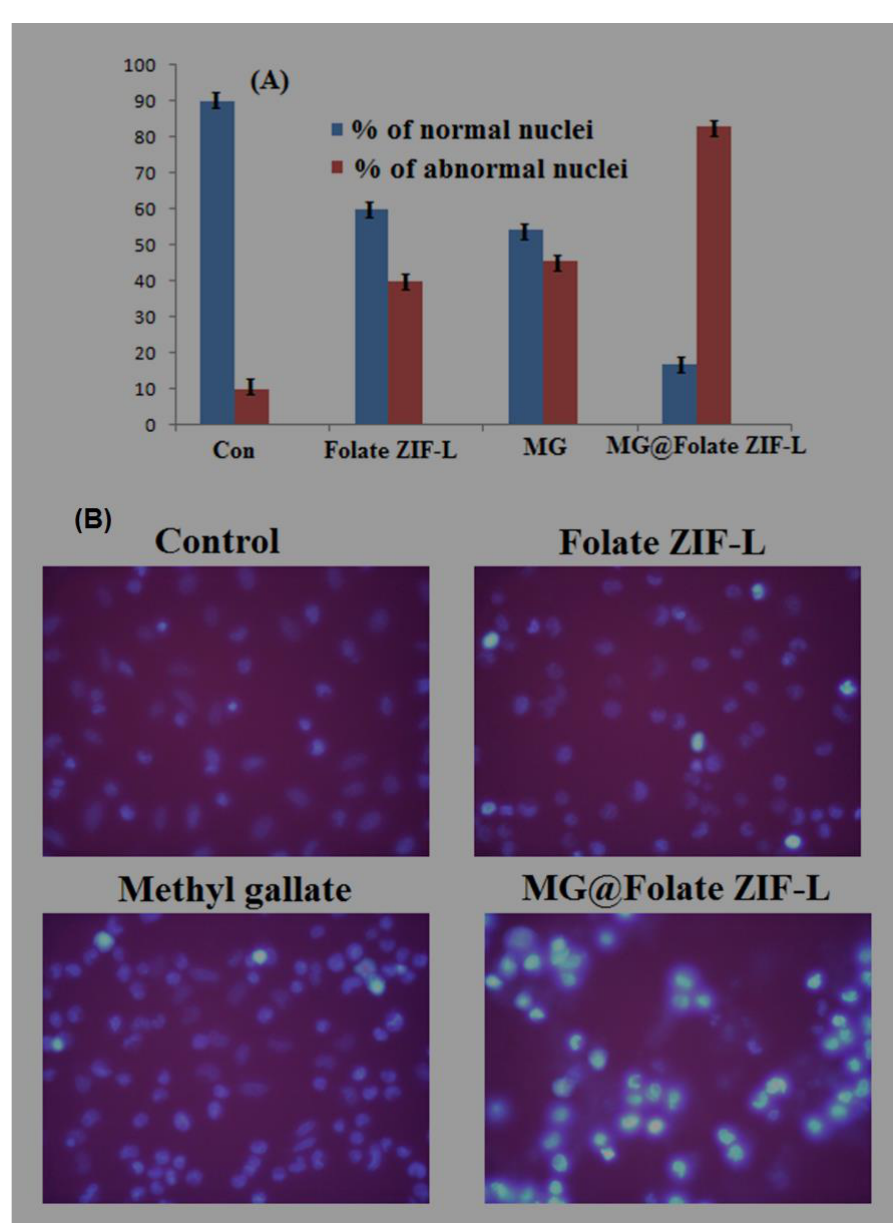
Figure 12. ( A ) Quantitative evaluation of normal and abnormal nuclei; ( B ) microscopic images of nuclear morphology changes of cells treated with MG@Folate ZIF-L nanoframeworks.